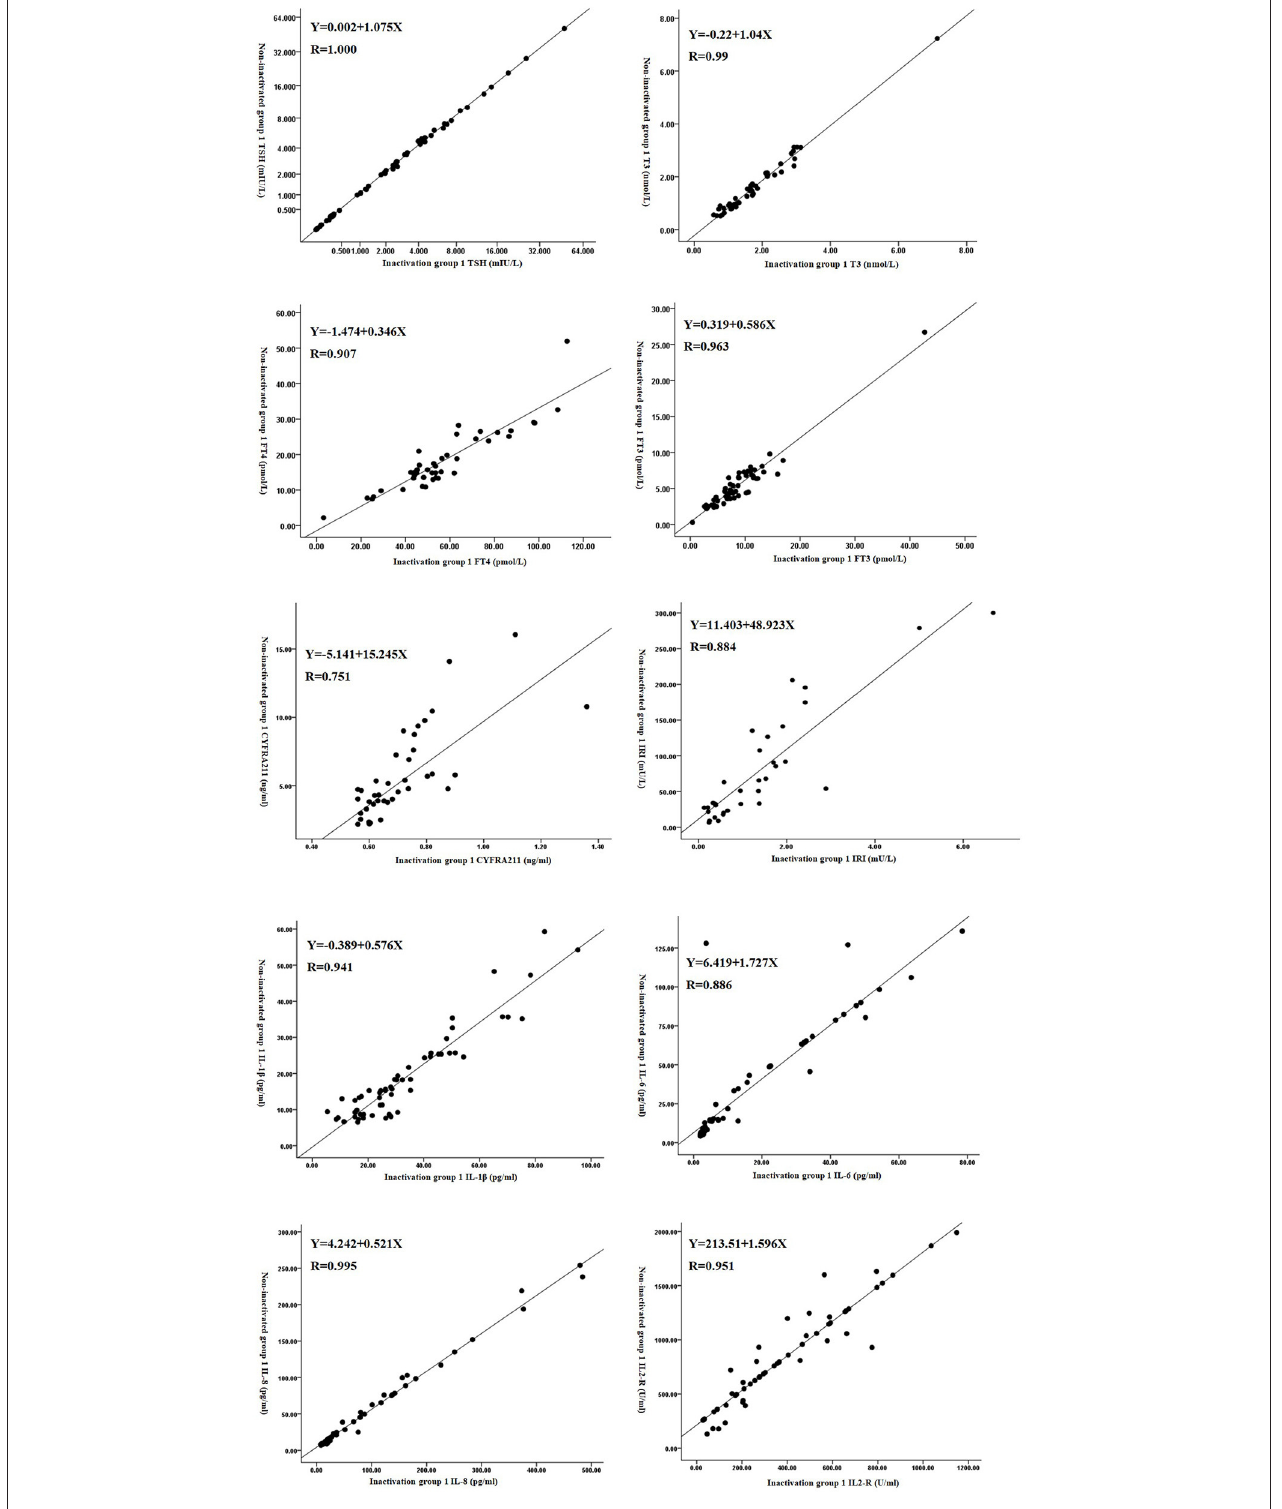
FIGURE 1 | Scatter diagram of the detection levels before and after the inactivation of some test items.